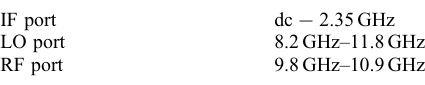
TABLE I Frequency Ranges Where the Reflection Coefficient of Each Port is Less Than (cid:2) 10dB. IF port